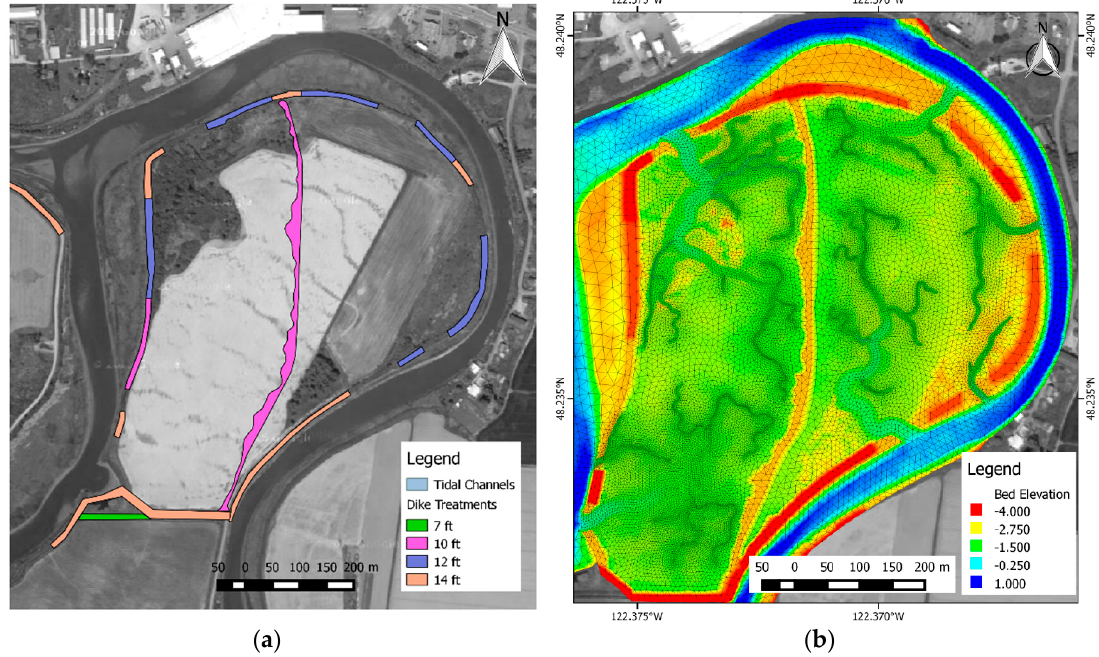
Figure 6. Preferred alternative design ( a ) and grid ( b ) for the zis a ba site.